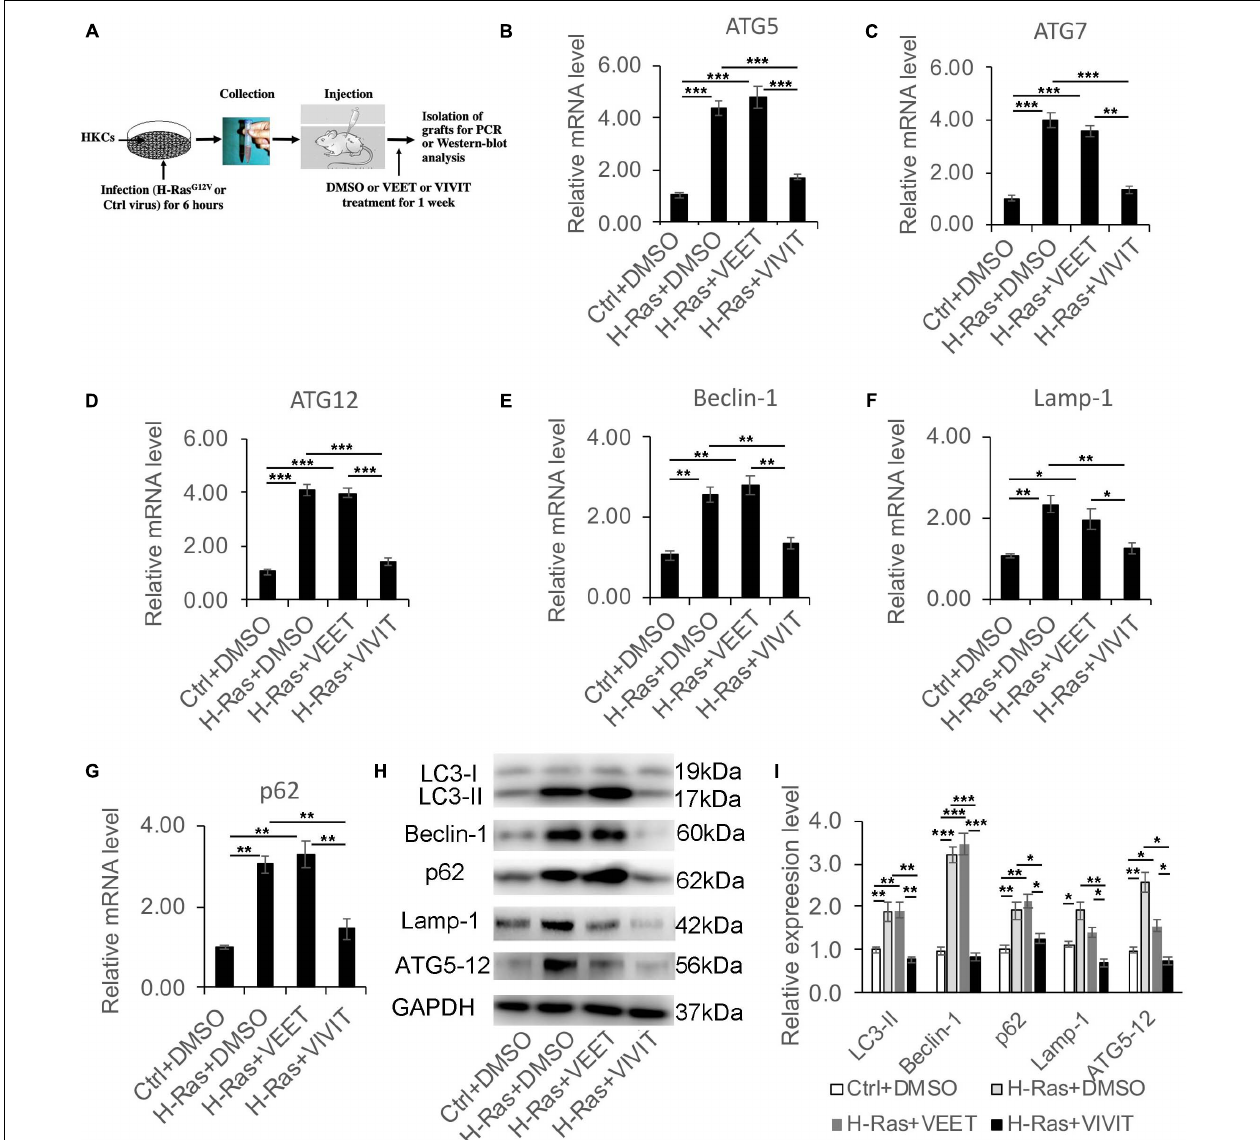
FIGURE 3 | Nuclear factor of activated T cells inhibitor VIVIT suppresses the increased expression of autophagy-associated genes induced by the overexpression of H-Ras in vivo . (A) Scheme of the in vivo assay: Human keratinocytes (HKCs) were infected with a H-Ras G 12 V expressing or a control retrovirus for 6 h, then were subcutaneously injected into the dorsal skin of NU/NU mice, after which the mice were treated with DMSO, VEET, or VIVIT by intraperitoneal injection. One week later, the grafts were collected for RT-PCR and western-blot analysis of autophagy-associated genes. (B–G) RT-PCR analysis of autophagy-associated genes as indicated from the grafts collected as shown in panel (A). (H) The grafts collected were lysed for immunoblotting analysis of autophagy-associated genes LC3, Beclin-1, p62, Lamp-1, and ATG5-12, GAPDH as a loading control. (I) Quantification of western-blot analysis shown in panel (H) for the relative expression levels of LC3, Beclin-1, p62, Lamp-1, and ATG5-12. Four mice ( n = 4) were used in each group, and error bars represent means ± SD; p values are indicated with “*,” * p < 0.05, ** p < 0.01, *** p < 0.005 when comparing two corresponding groups indicated with the black lines by Student’s t